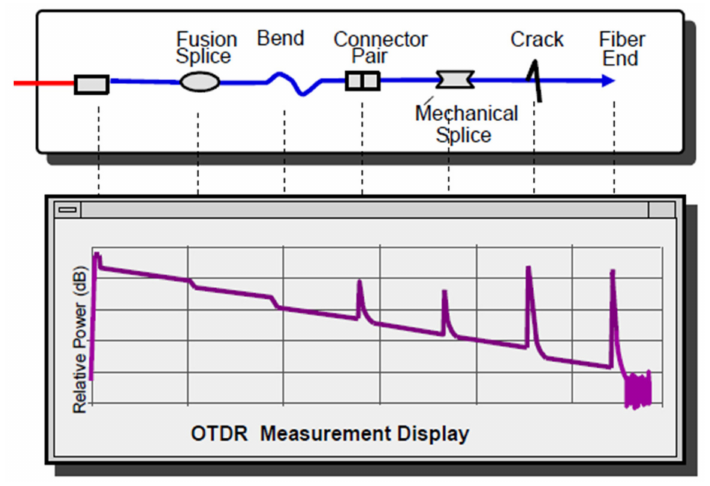
Figure 2. OTDR trace.